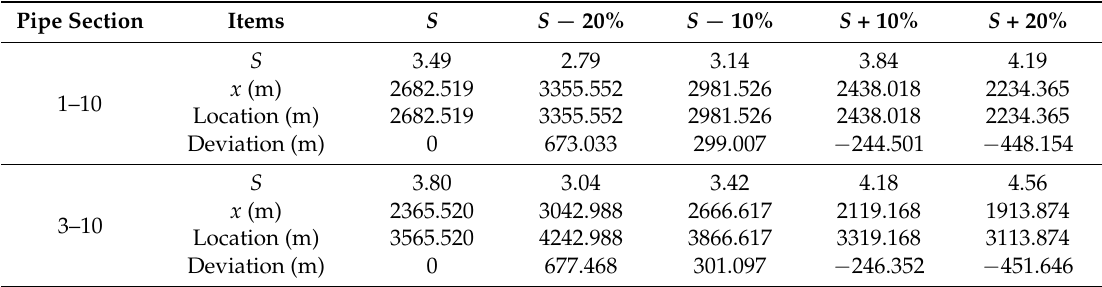
Table 4. Sensitivity analysis of parameter S